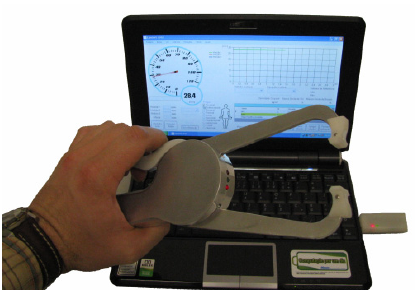
Figure 4. Digital under-bed scale system